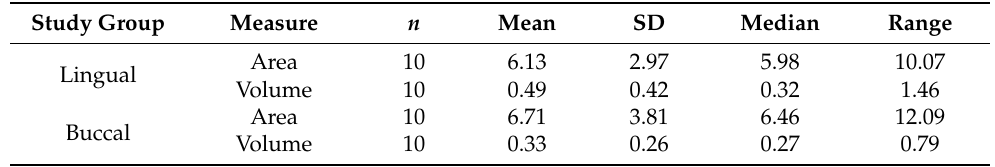
Table 3. Descriptive statistics of the area (mm 2 ) and volume (mm 3 ) of enamel removed after cement polishing of the lingual and buccal multibracket appliance